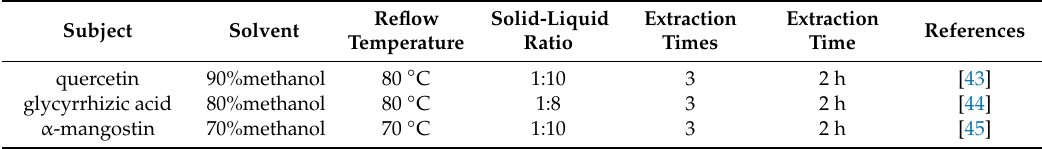
Table 10. The separation conditions of three active molecules.